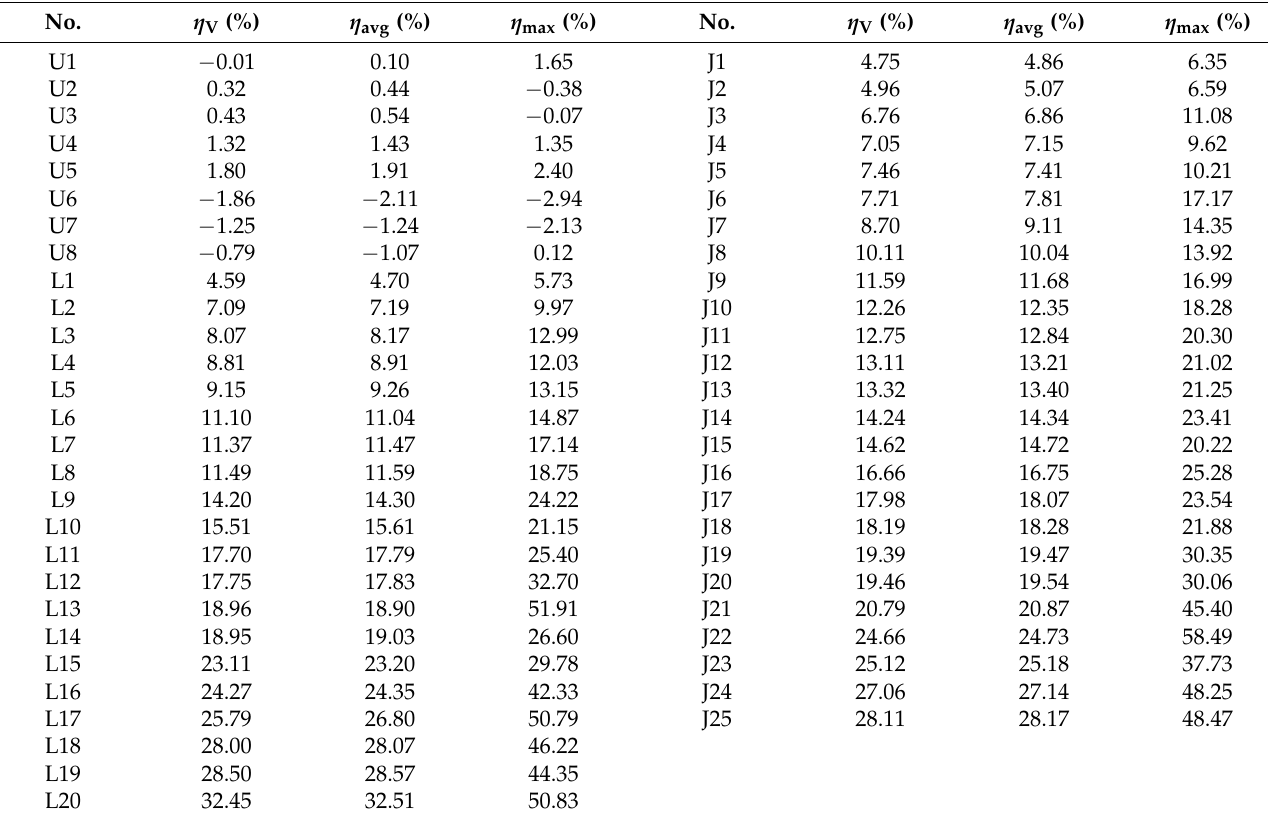
Table 3. Average volume loss, average cross-section loss, maximum cross-section